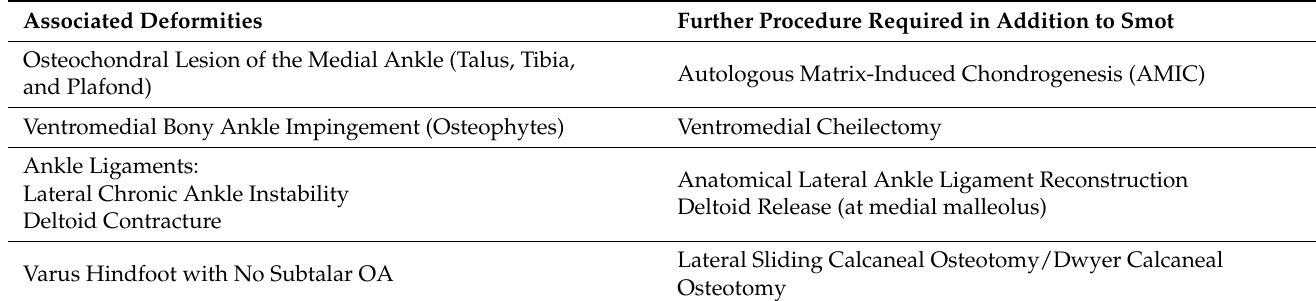
Table 3. Summary of Associated Deformities and Further Procedures Required in Addition to Supramalleolar Osteotomy